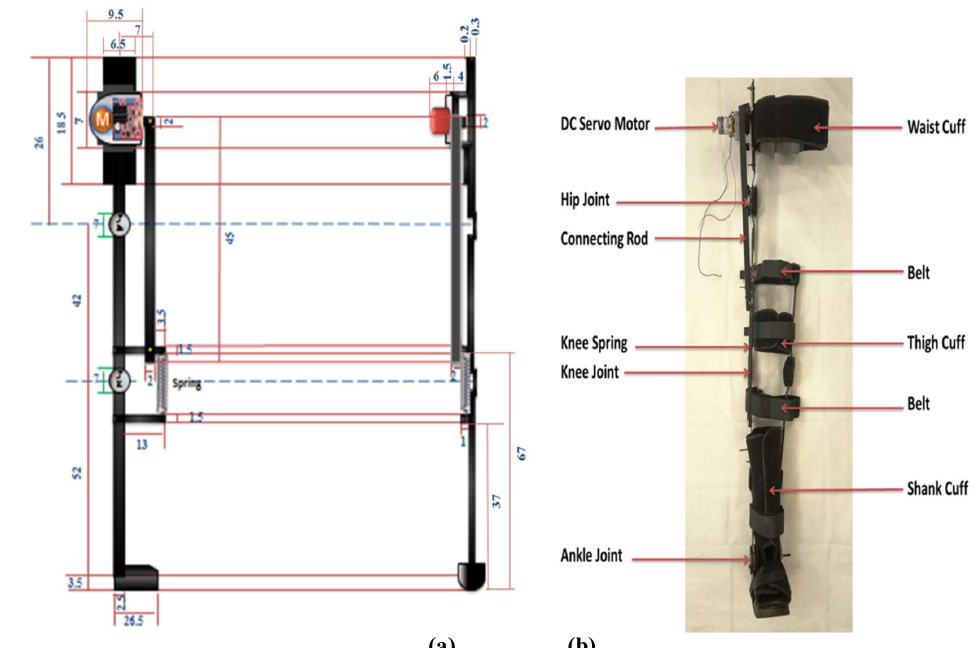
Fig.7. The proposed lower limb exoskeleton components (a) the schematic diagram of proposed Exoskeleton side and front view (all dimensions in cm), (b) the overall